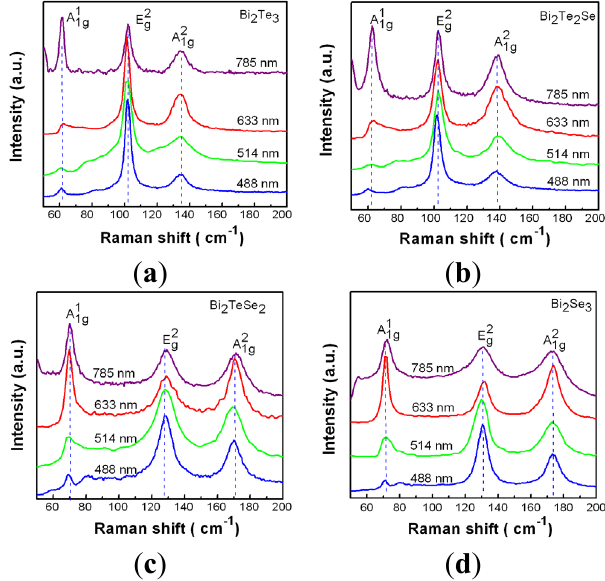
Figure 4. Raman spectra of ( a ) Bi 2 Te 3 , ( b ) Bi 2 Te 2 Se, ( c ) Bi 2 TeSe 2 and ( d ) Bi 2 Se 3 measured at four different excitation wavelengths (488 nm (2.54 eV), 514 nm (2.41 eV), 633 nm (1.96 eV), and 785 nm (1.58